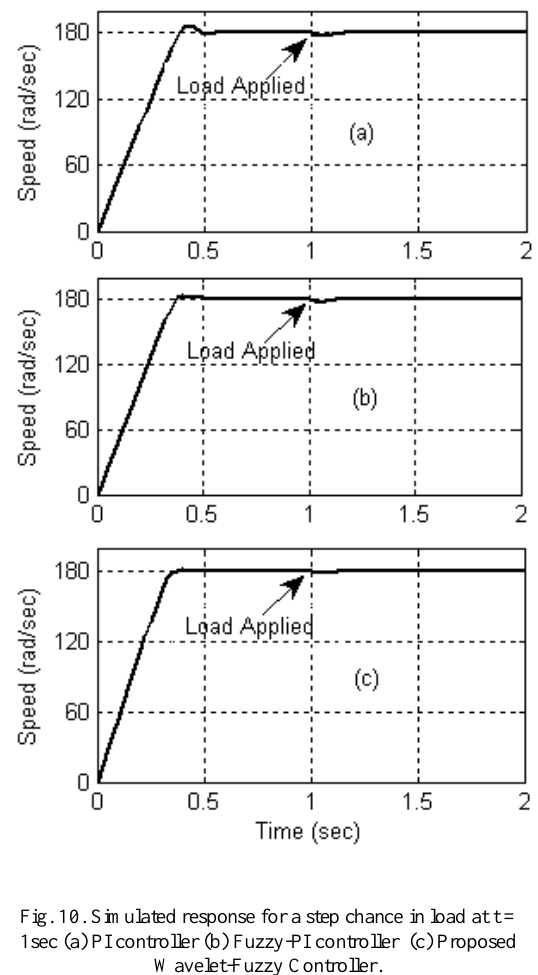
Fig. 10. Simulated response for a step chance in load at t =